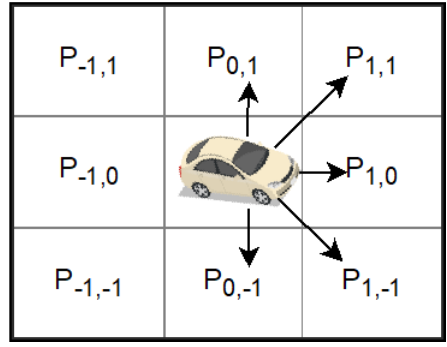
Figure 4. The next time-stamp target cells.